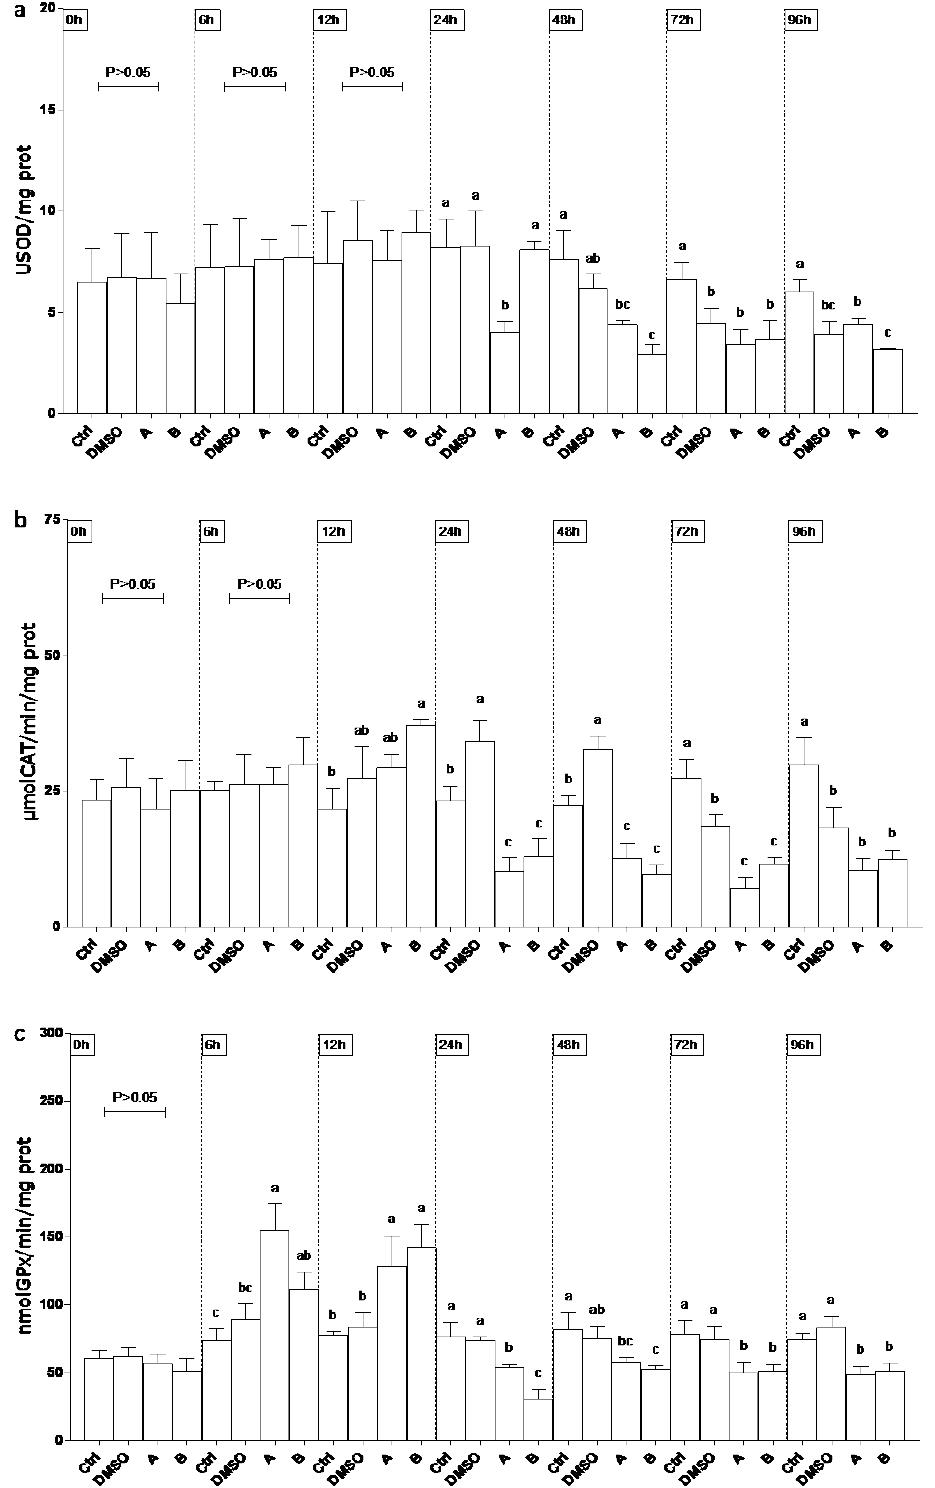
Figure 2. Superoxide dismutase (SOD; ( a )), catalase (CAT; ( b )) and glutathione peroxidase (GPx; ( c )) activity in epithelioma papulosum cyprini (EPC) cell line exposed to concentrated drinking water from sites A and B. Ctrl denotes control. Different lowercase letters indicate statistically significant differences ( p < 0.05) between the two groups at the same time point.